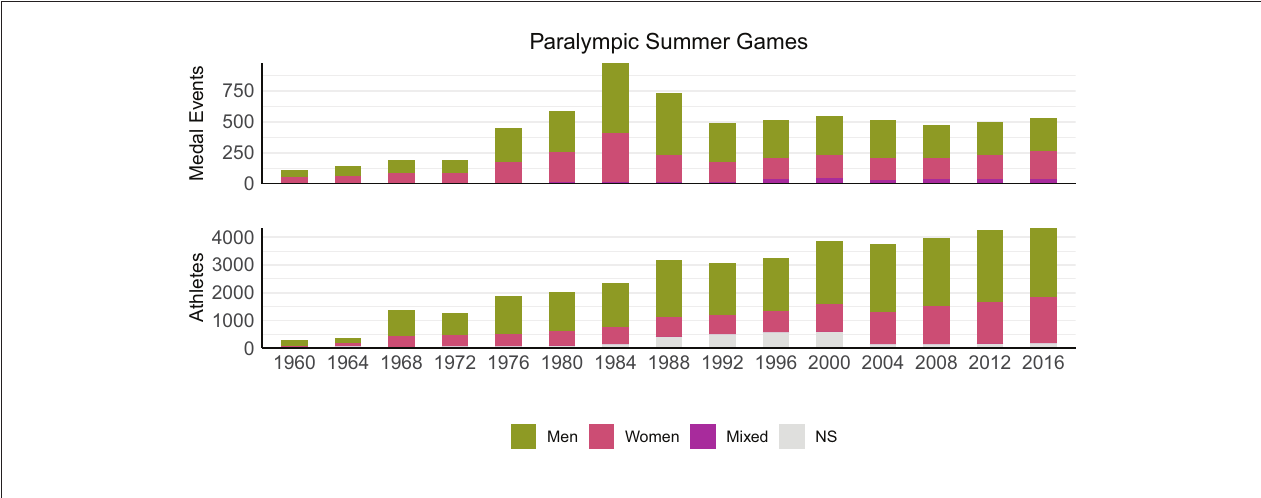
FIGURE 3 | Schematic overview showing the split between medal events for female-only, male-only, and mixed competitions, as well as the number of female and male athletes during each of the SG. Some athletes participated in more than one sport; in these cases, the number of athletes were counted once per sport.